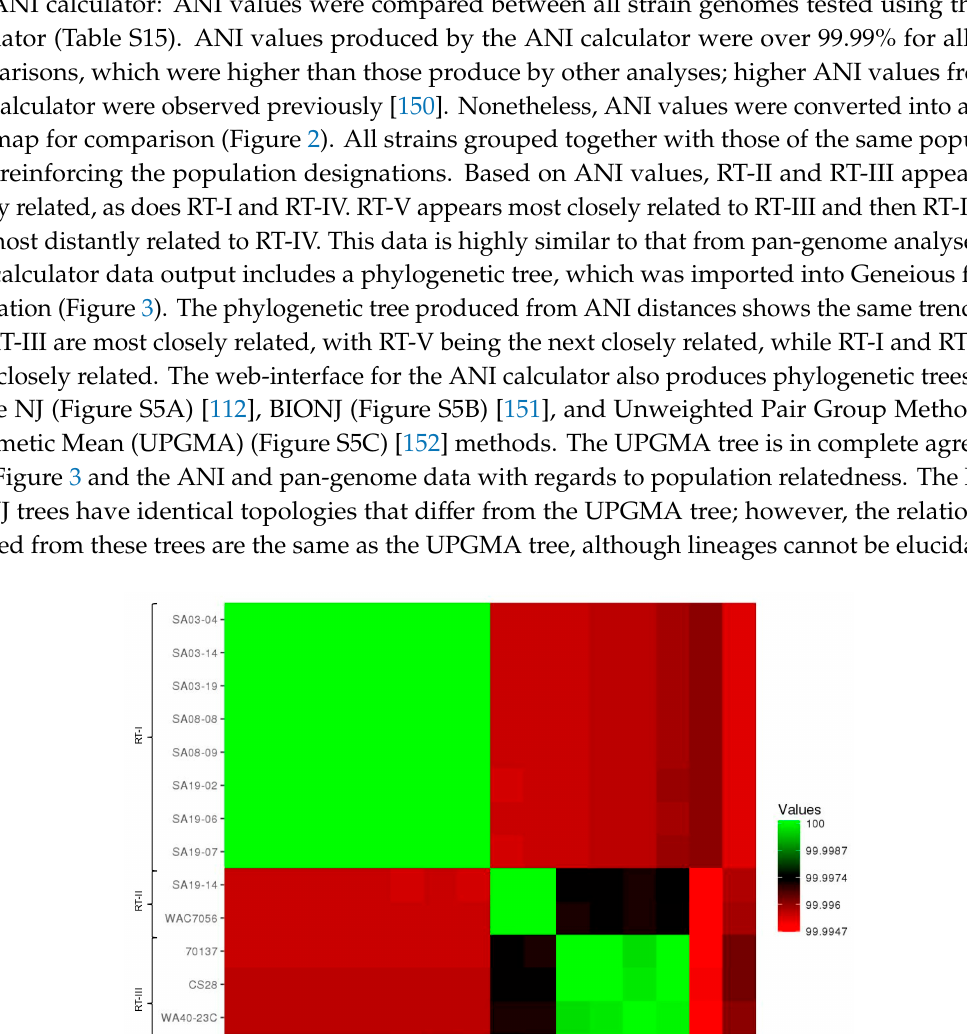
Figure 3. Phylogenetic tree based average nucleotide identity distances between R. toxicus strains used in this study. The ANI calculator was used to calculate ANI distances. The tree data were input